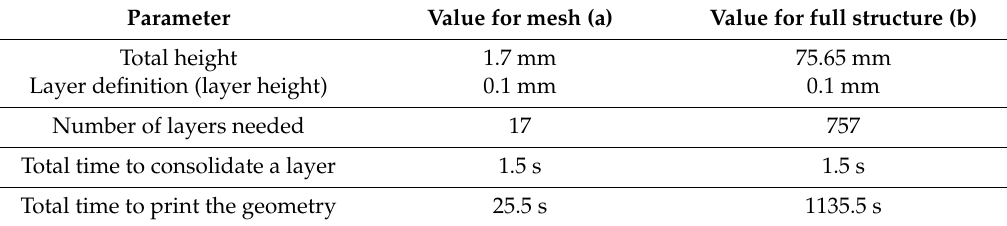
Table 4. Third and fourth scenarios for comparison: Estimation of the total time to print utilizing